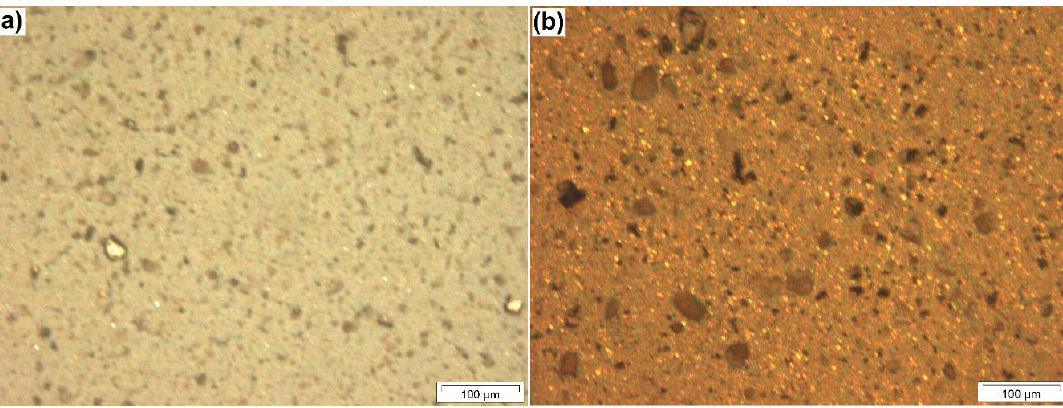
Figure 1. Optical microscopy for two compositions: ( a ) Al-15 Fe 3 O 4 and ( b ) Al-30 Fe 3 O 4 -20SiC.